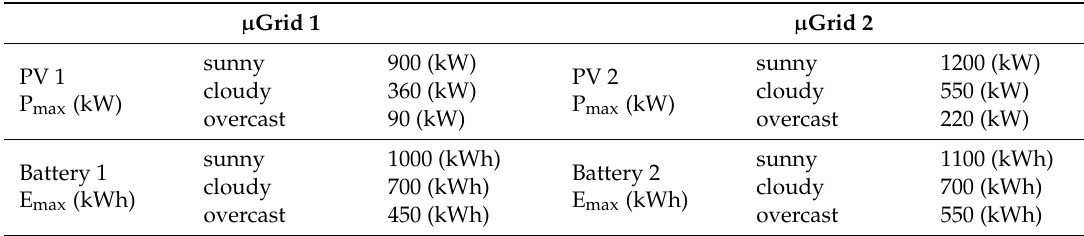
Table 1. DERs sizing